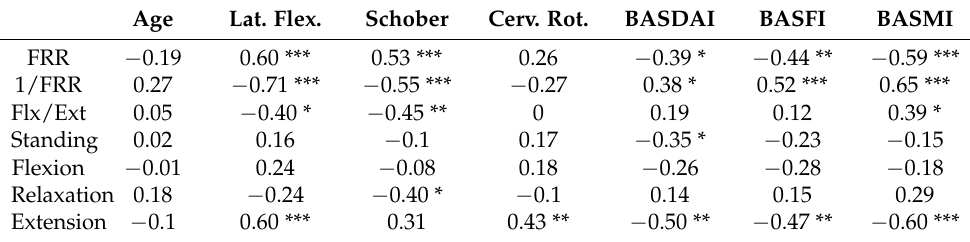
Table 3. Correlations between sEMG measures and other variables for axSpA